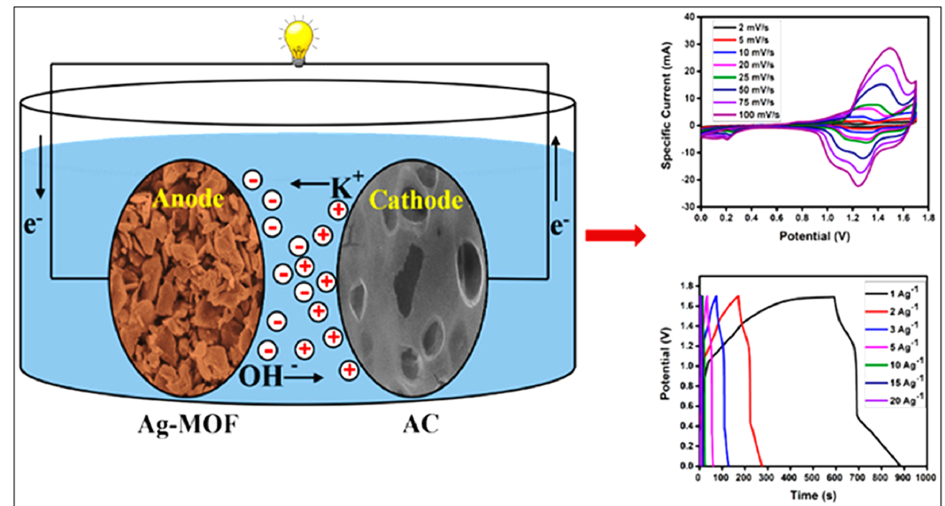
Figure 19. Schematic representation and electrochemical performance of the silver–MOFelectrode material in the supercapacitors [96]. Reproduced with permission.